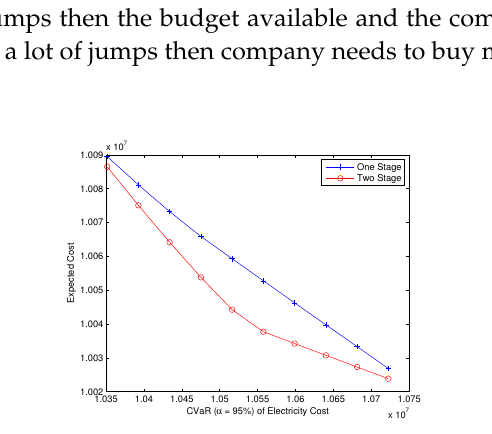
Figure 11. Multi stage recourse in problem P ret